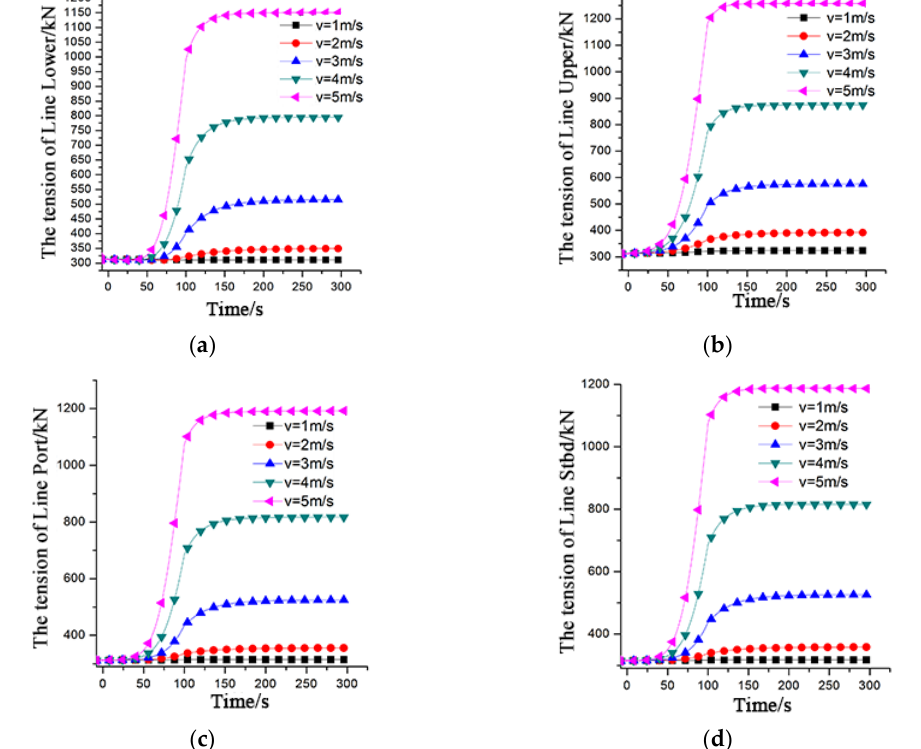
Figure 15. Shape changes of rigid truss trawl in straight-line towing at v = 3 m/s. Figure 16. Shape changes of rigid truss trawl in straight-line towing at v = 4 m/s.